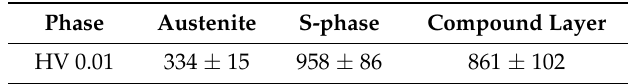
Table 5. Microhardness of the different phases in the AISI 316L HVOF coating.